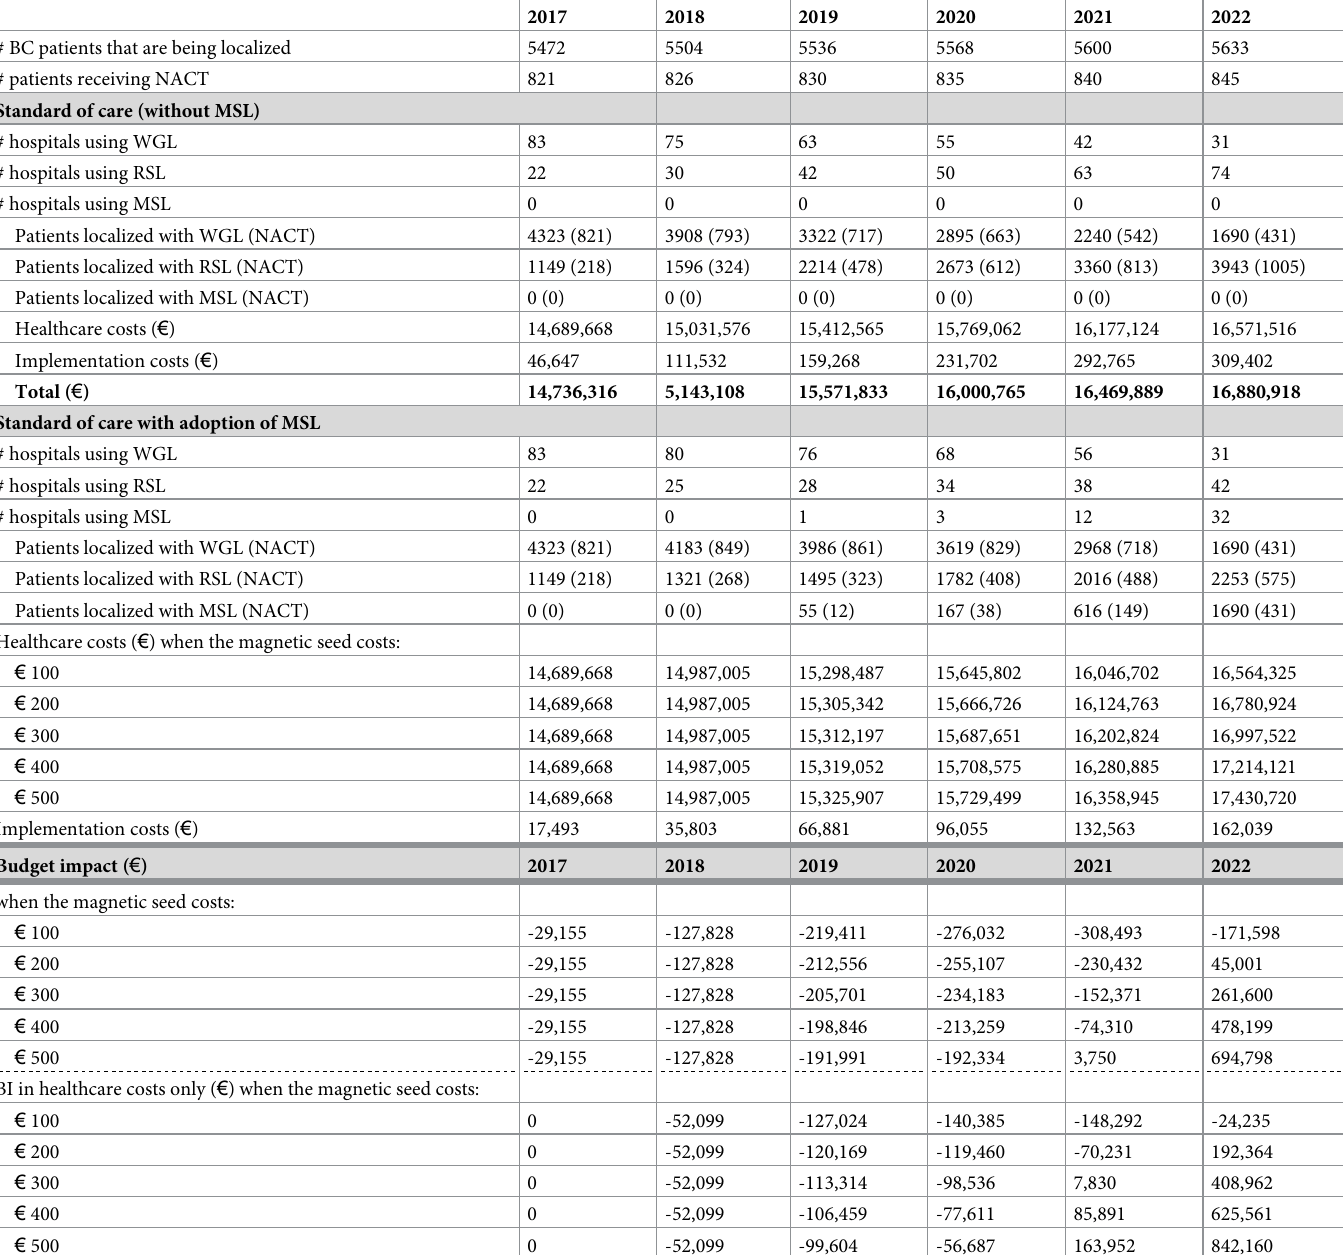
Table 2. Base case results of the budget impact analysis of adopting magnetic seed localization (MSL) in breast conserving